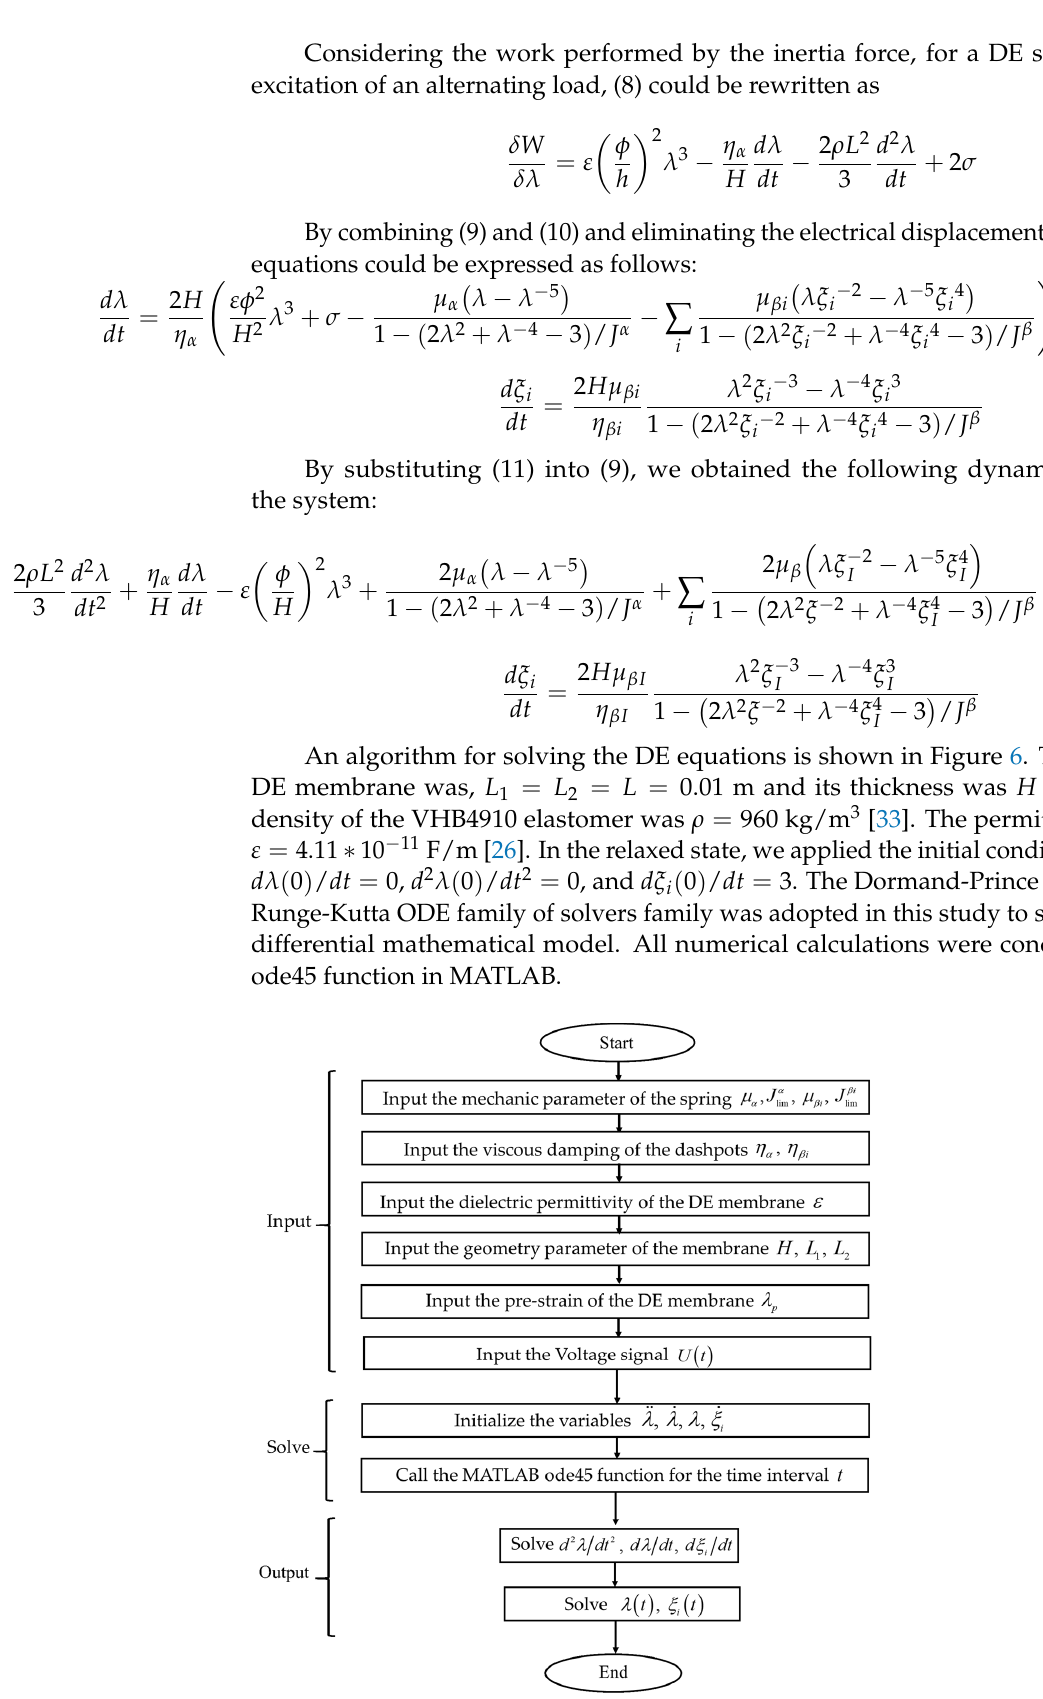
Figure 6. Algorithm for solving the governing equations of the DE.